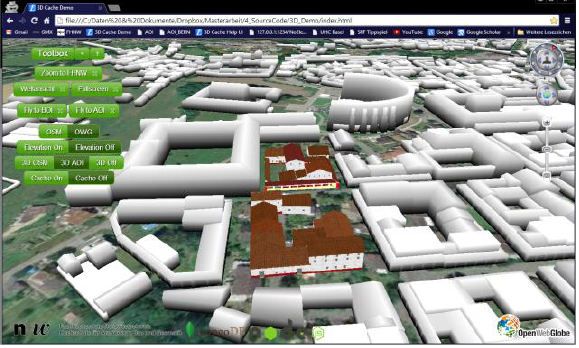
Figure 9. Real-Time Rendering of the Augusta Raurica Dataset in the virtual globe – textures are streamed per building.